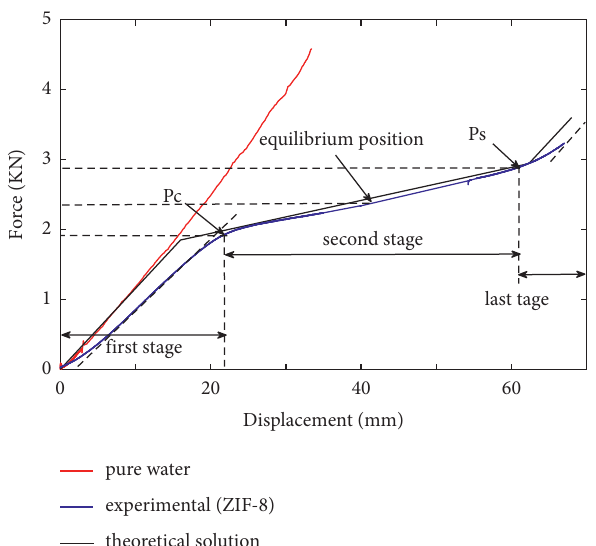
Figure 6: The force-displacement relationship.